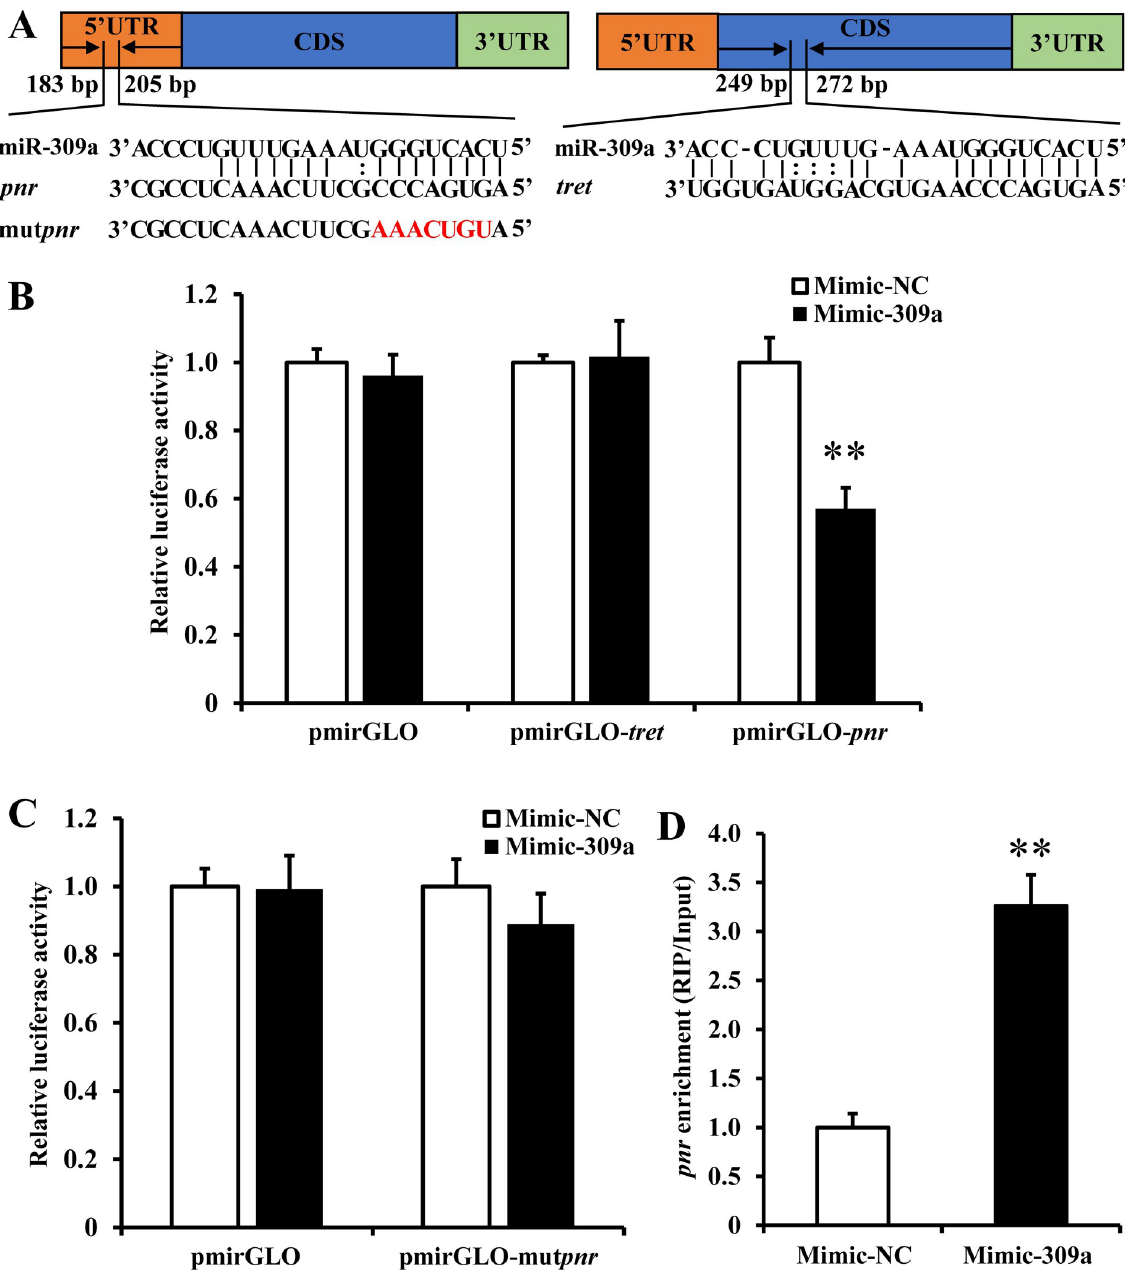
Fig 4. miR-309a targets pnr in B . dorsalis . (A) Binding region information for pnr and tret . (B) Dual luciferase reporter assays in wild types of pnr and tret . (C) Dual luciferase reporter assays in mutant pnr using HEK293T cells co-transfected with miRNA mimic and pmirGLO/ recombinant pmirGLO vectors containing the predicted binding sites or mutant binding sites for B and C . Data are means ± SE (error bars) of four biological replications. (D) miR-309a targets pnr in vivo as demonstrated by RNA immunoprecipitation assay. Data are means ± SE of three biological replications. The differences between means were analyzed by Student’s t test for B , C , and D . For the significance test: unmarked � indicates not significant; �� P <